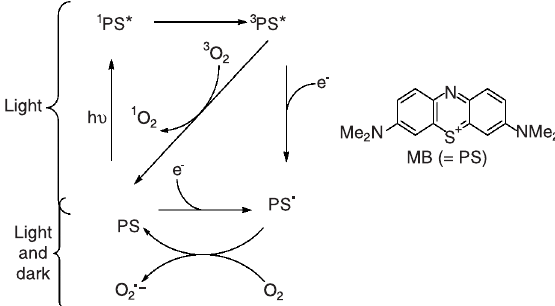
Figure 1. Electron and energy transfer reactions in which meth- ylene blue (MB) is involved in the presence (above) and in the presence and absence of light (below). PS is photosensitiser in the singlet ( 1 PS) and triplet ( 3 PS) excited states; 3 O 2 and 1 O 2 are the ground and excited (singlet) states of molecular oxygen (O 2 ). PS . is the reduced species of PS, and O 2.- is the anion radical